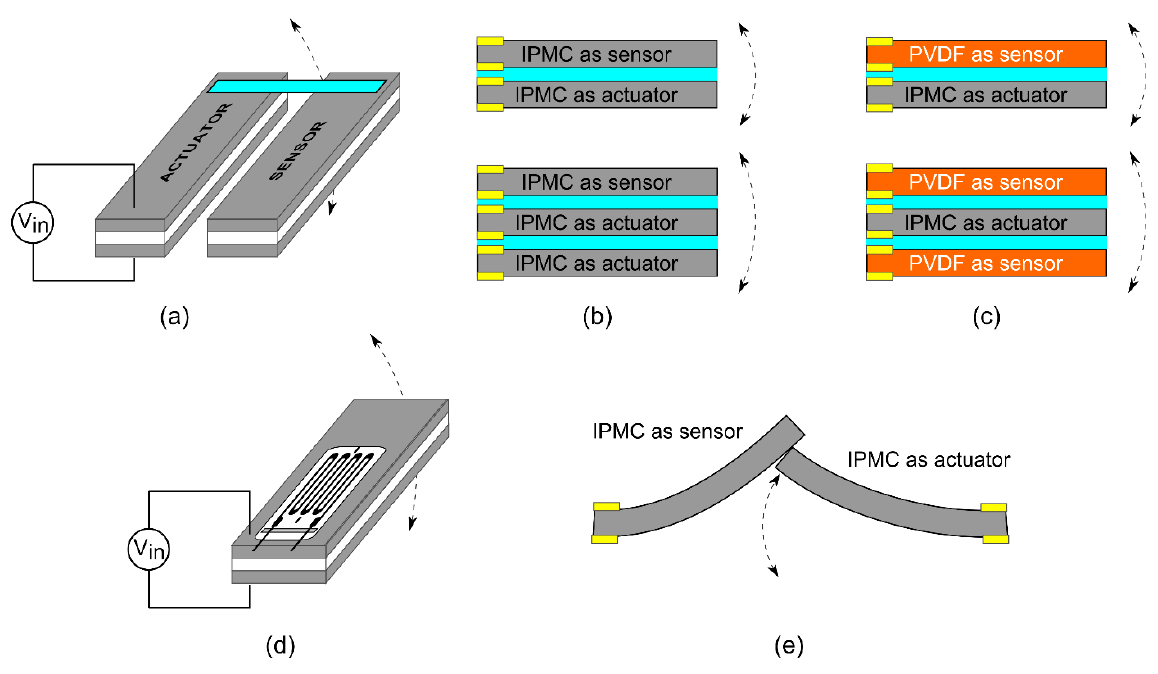
Figure 12. Mechanically coupled integrated sensing for ionic polymer actuators. ( a ) Actuator and sensor placed in parallel while linked by a non-conductive rigid